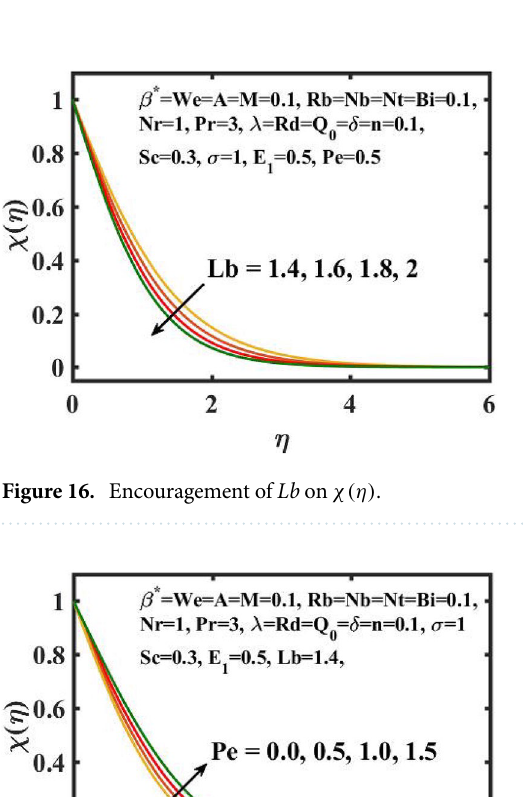
Figure 15. Encouragement of Sc on φ(η) .